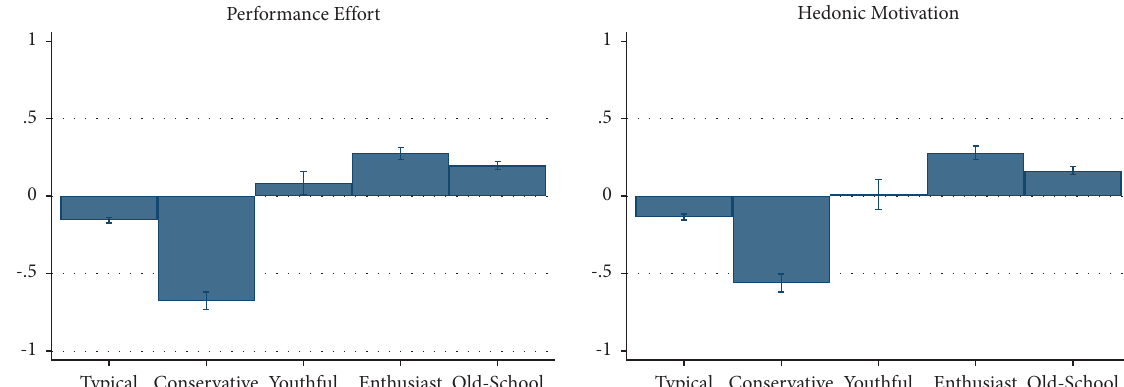
Figure 2: Value latent constructs: performance efort and hedonic motivation. Latent factor scores on vertical axis. Four items used for generating the PE-latent variable: it is expected that a CAC would be useful in meeting daily mobility needs; using a CAC would help reach the destination more safely; using a CAC would help reach the destination more comfortably; it is assumed that a CAC would be useful in daily life. Tree items used for generating the HM-latent variable: using a CAC would be fun; using a CAC would be entertaining; using a CAC would be enjoyable.